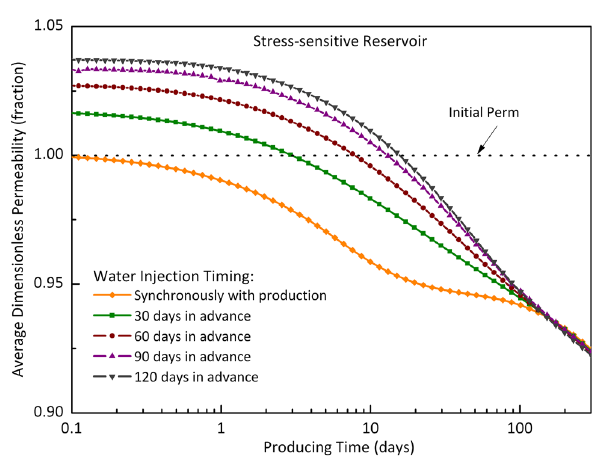
Fig. 14 Average formation permeability under different water injec- tion